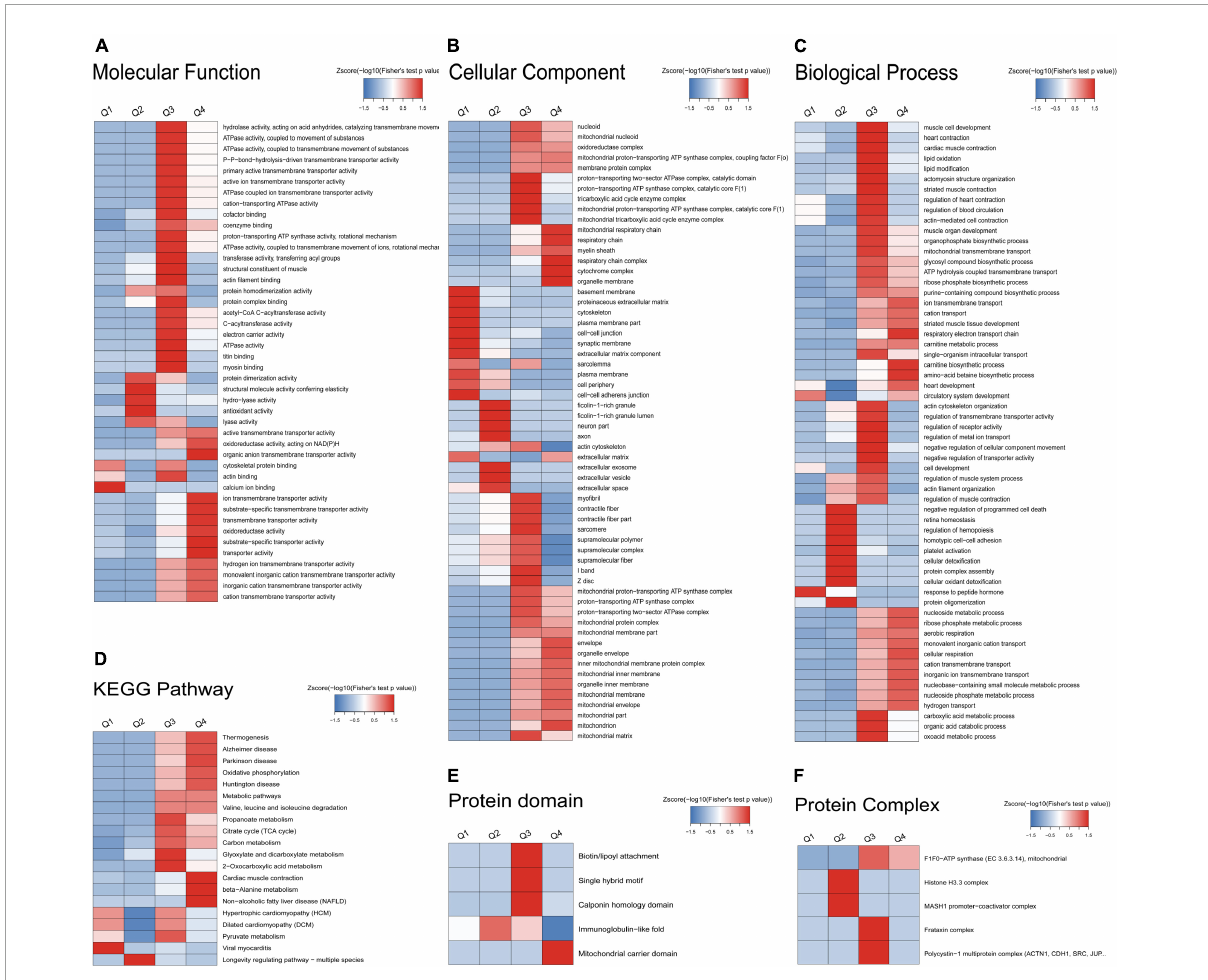
FIGURE5 Enrichment-based clustering analysis of GO, KEGG pathway, protein domain, and protein complex of the AF/SR differentially expressed acetylated proteome in LAA tissues. (A) Molecular function. (B) Cellular component. (C) Biological process. (D) KEGG pathway. (E) Protein domain. (F) Protein complex. GO, gene ontology; KEGG, Kyoto Encyclopedia of Genes and Genomes; AF, atrial fibrillation; SR, sinus rhythm; LAA, left atrial